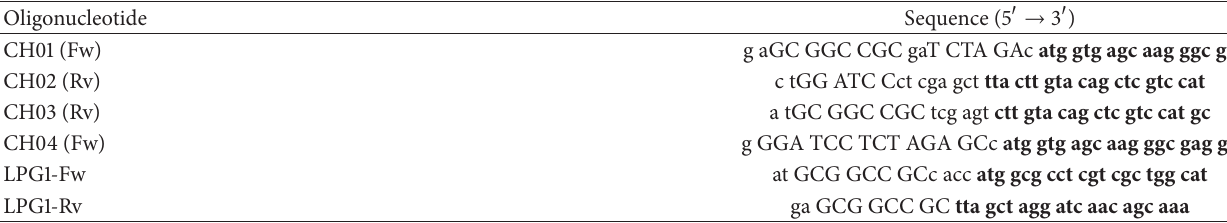
Table 1: Oligonucleotides used in this